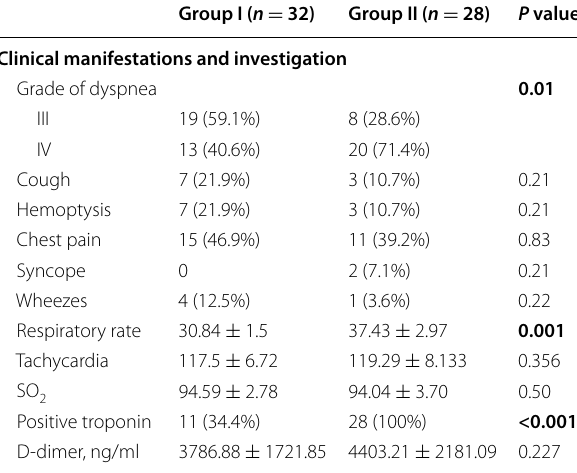
Table 2 Clinical manifestations and investigation among enrolled patients